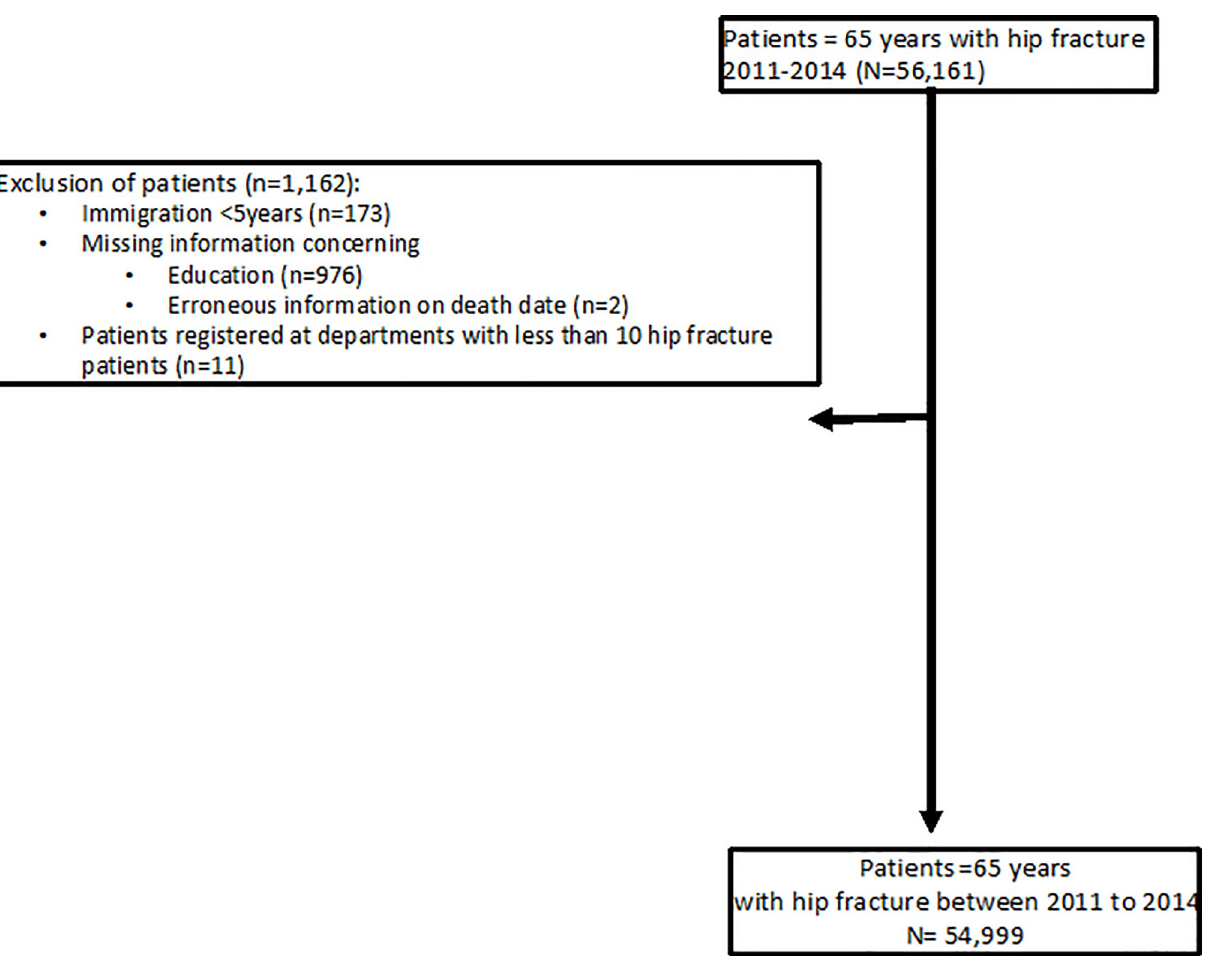
Fig 1. Flowchart patient